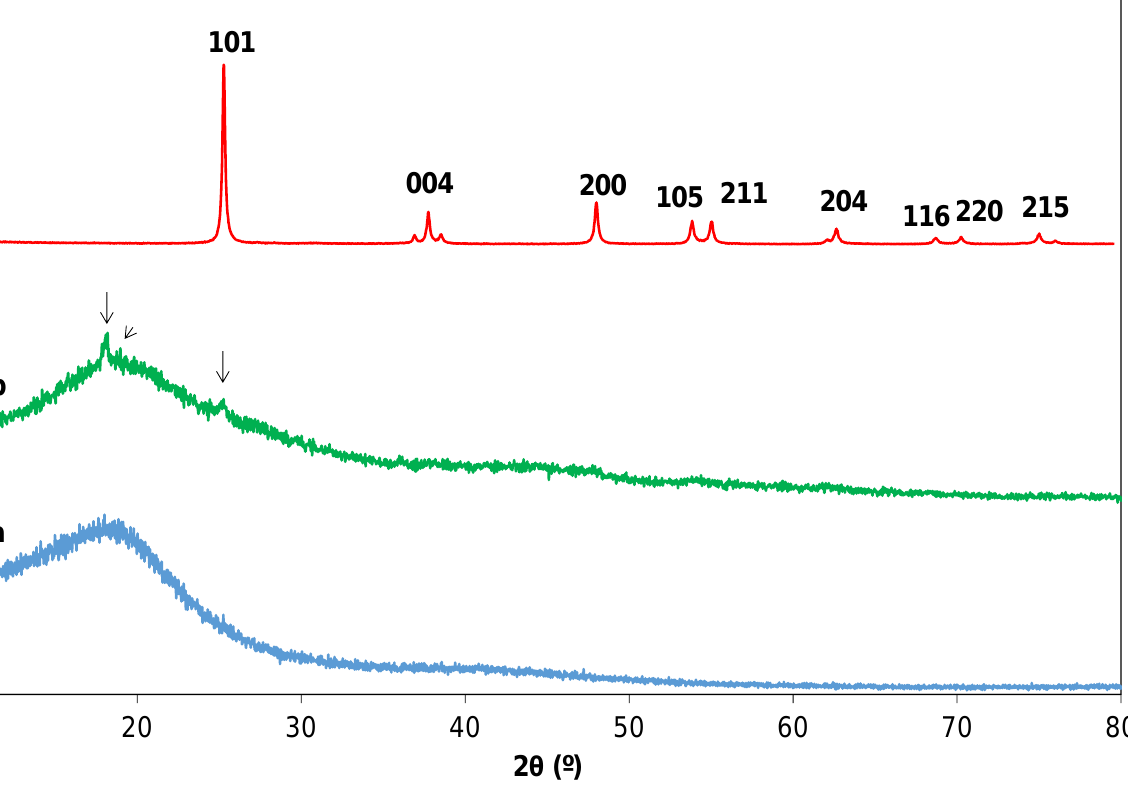
Figure 7. Indexed XRD patterns of the template (a), the Ti 1 − x Tb x [(OH) 4 − u Cl v ]@PST–PDVB (x = 0.012) intermediate product after 5 h of reaction (b) and Ti 1 − x Tb x O 2 − w ′ (x = 0.012) after calcination at 550 ° C for 30 min (0.12%_550) (normalized XRD pattern) (c). The peaks at 18.18, 18.74 and 25.26 ° that can confirm the implantation of TiCl 4 and TbCl 3 in the PST–PDVB matrix are indicated with arrows. 2.3. Thermal Evolution of the Ti 1 − x Tb x [(OH) 4 − u Cl v ]@PST–PDVB followed by DTA-TG Analysis